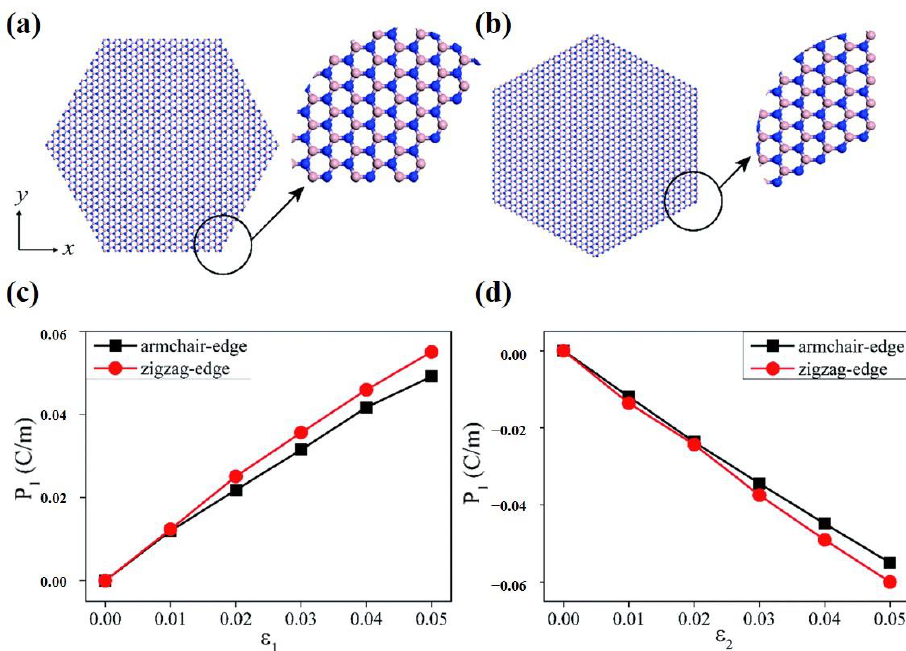
Figure 8. ( a , b ) show the atomic structures of armchair and zigzag edges of a hexagonal shaped boron nitride nanosheets structure, respectively [101]. Reprinted with permission from [101]. Copyright 2018 Royal Society of Chemistry. ( c , d ) show the polarization changes of hexagonal shape boron nitride nanosheets structures along the x- and y-directions, respectively, as a result of stretching [101]. Reprinted with permission from [101]. Copyright 2018 Royal Society of Chemistry.